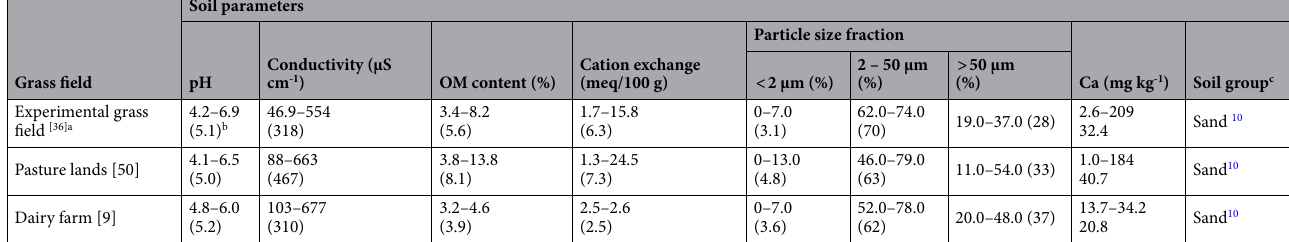
Table 1. Physicochemical parameters of the soils. a Values within square brackets in column 1 represents samples analyzed. b Values within parenthesis represent the arithmetic mean corresponding to the respective range. c Soil group is based on the criteria described in IAEA-TRS-472 10 .